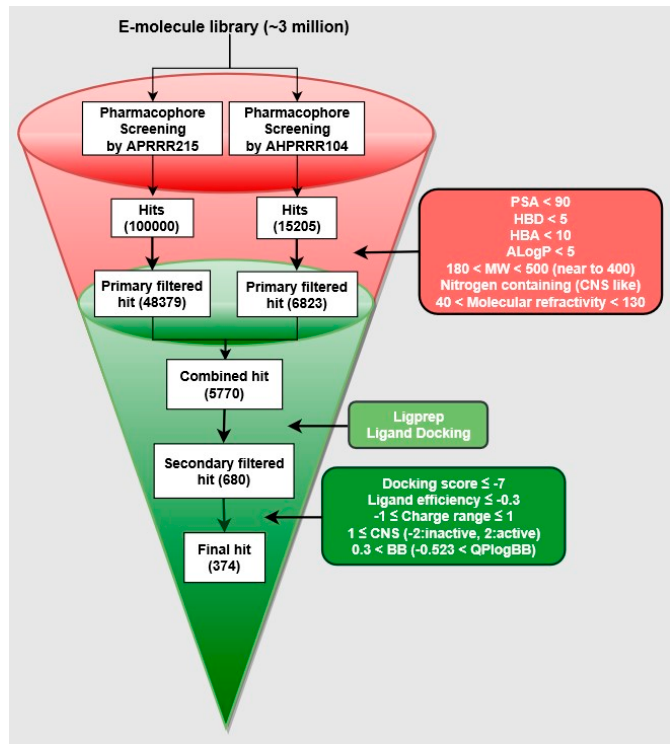
Figure 9. Hit selection workflow.